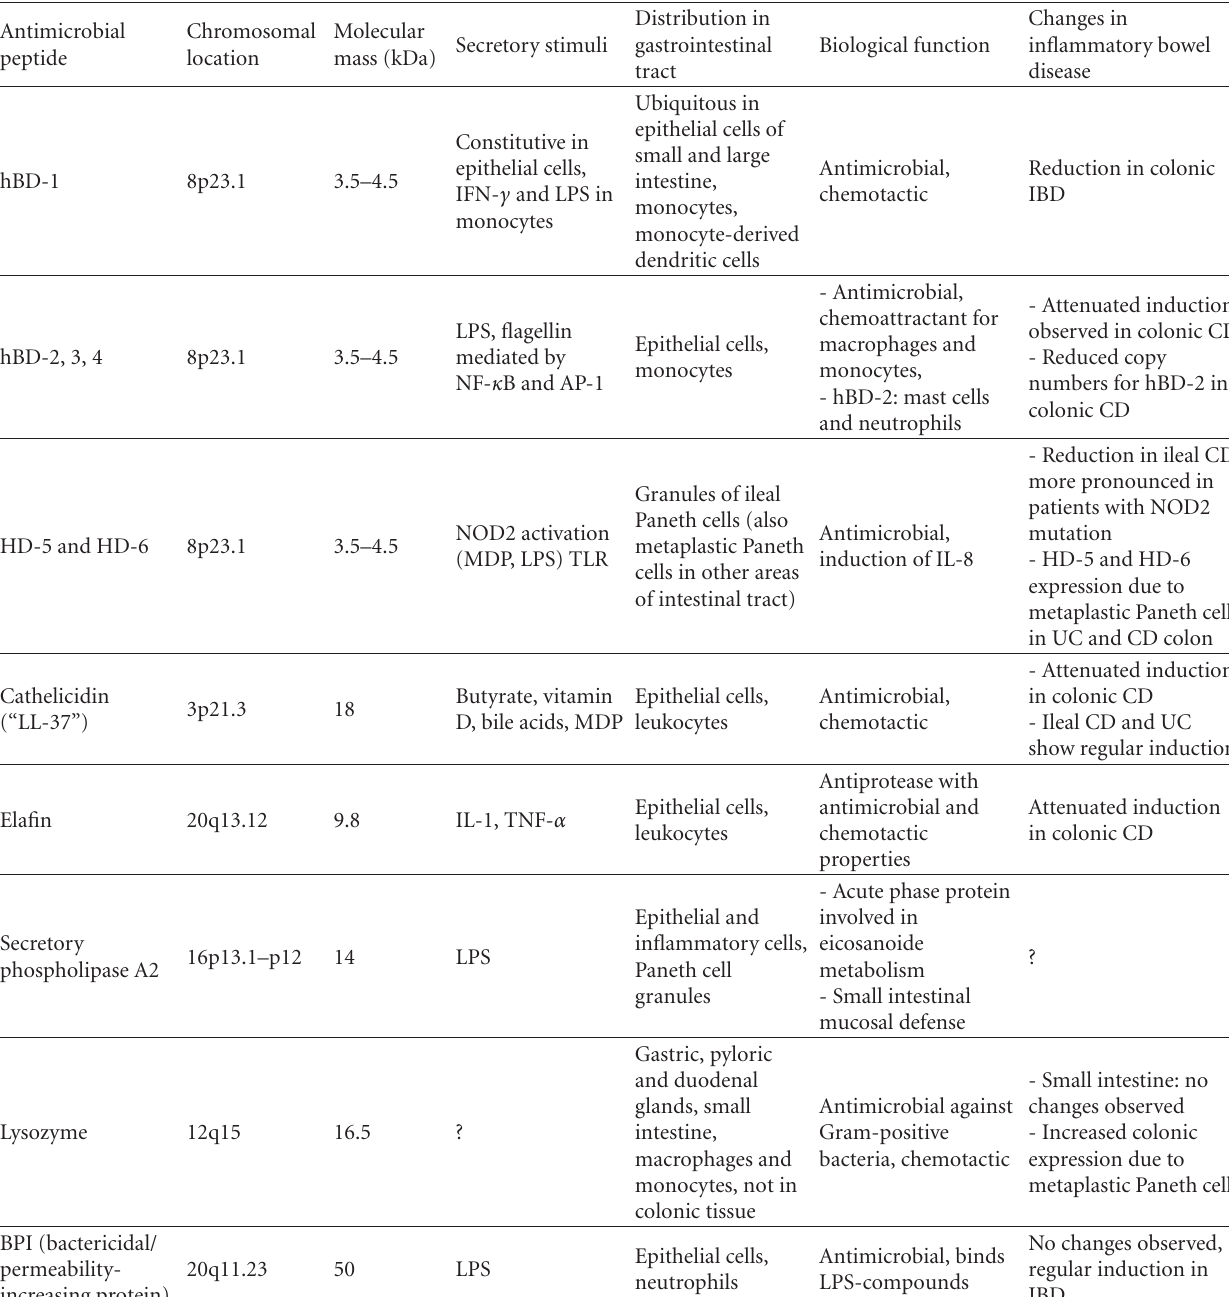
Table 1: Antimicrobials in the gastrointestinal